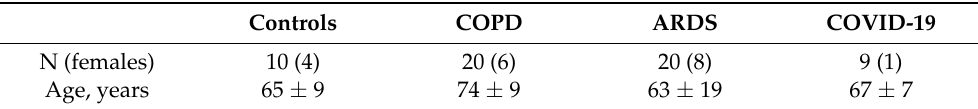
Table 1. Patients and subjects recruited for this